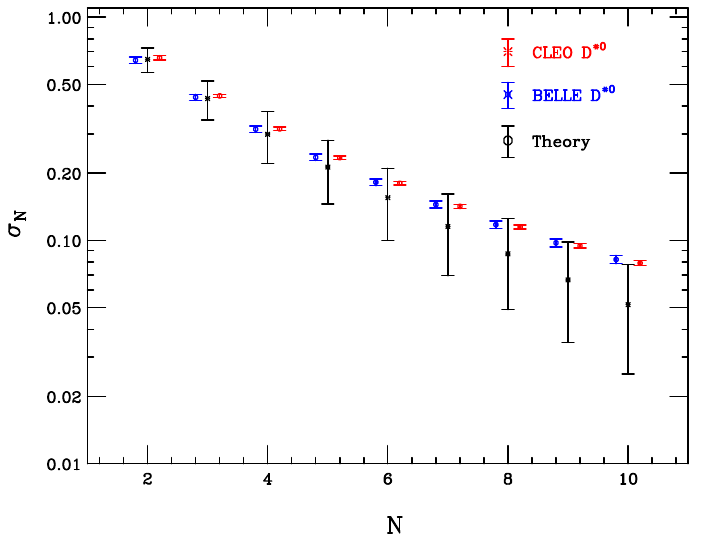
Figure 8. As in Figs. 6 and 7, but with the theory moments faring against BELLE and CLEO data on Figure 8. As in Figures 6 and 7, but with the theory moments faring against BELLE and CLEO data D ∗ + production. on D ∗ +